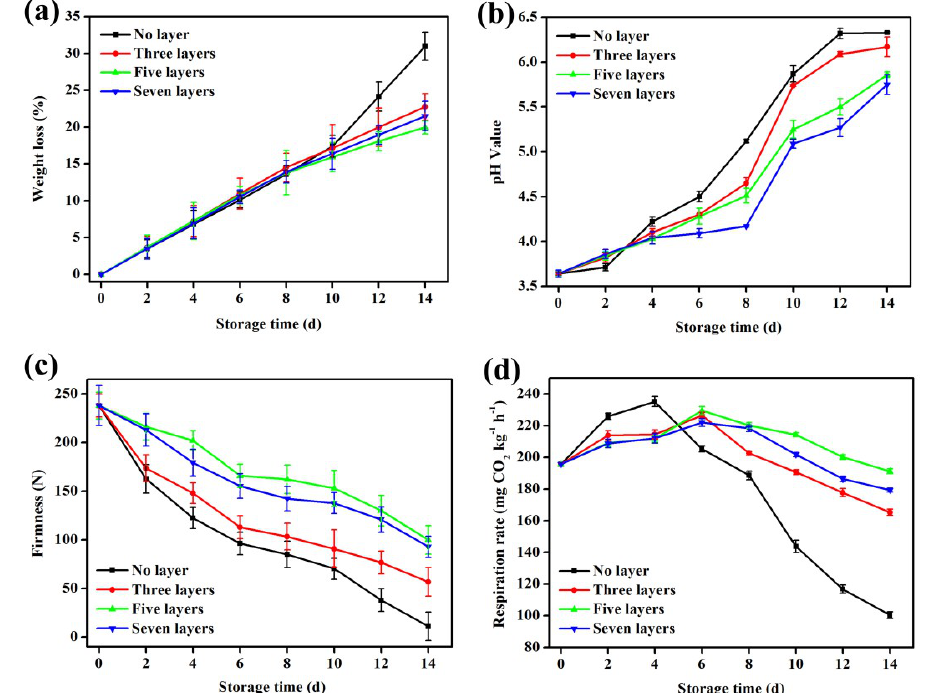
Figure 5. ( a ) Loss of quality during mango storage; ( b ) changes in the pH value during mango storage; ( c ) changes in firmness during mango storage; ( d ) changes in respiration rate during mango storage. Error bars represent the standard deviations of three replicates.